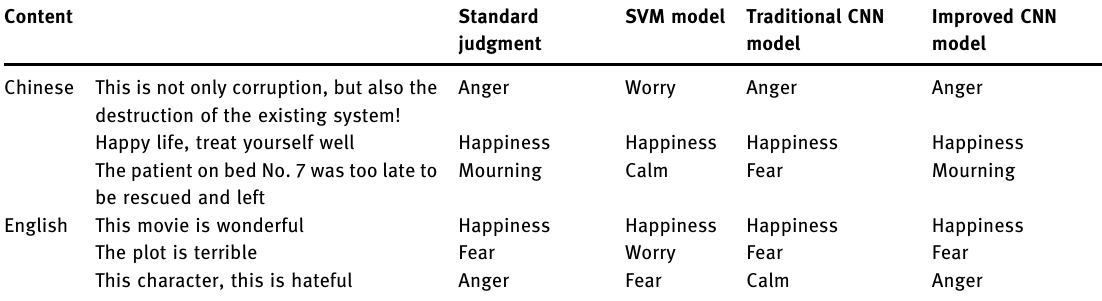
Table 3: Partial emotion classi fi cation results of Chinese and English texts by three classi fi cation models